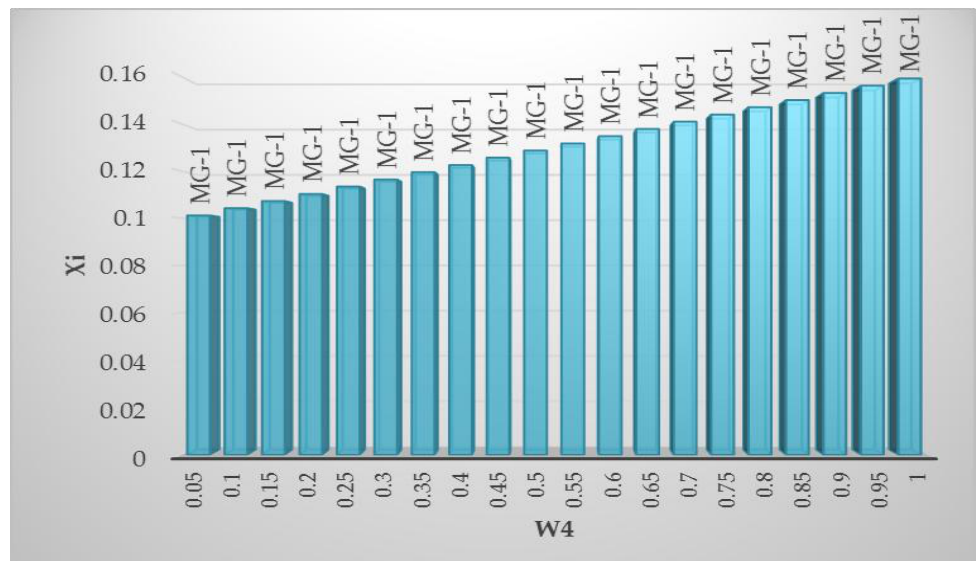
Figure 17. The weighted arithmetic mean ( X i ) depending on the reliability weighted index.